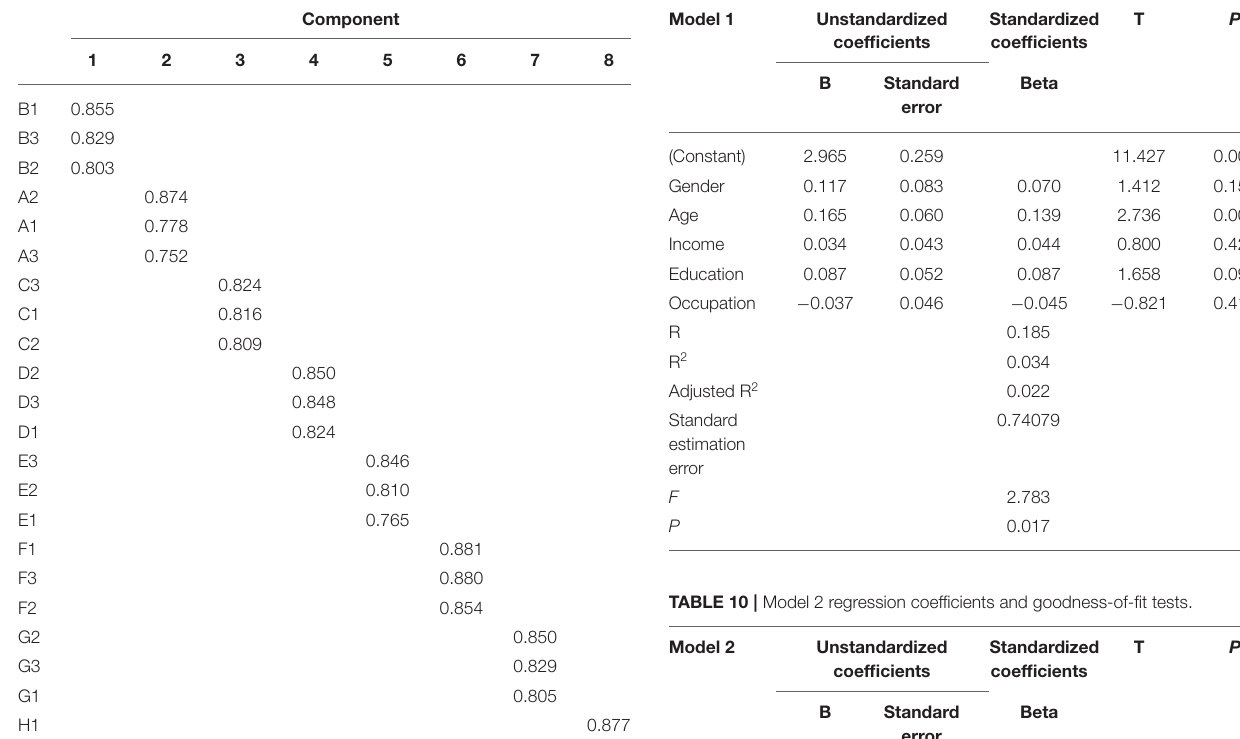
TABLE 8 | Rotated component matrix. TABLE 9 | Model 1 regression coefficients and goodness-of-fit tests.